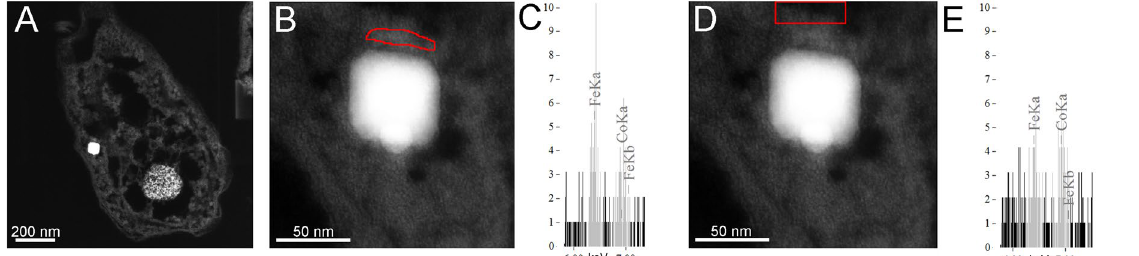
Figure 2. STEM-HAADF of thin-sections of a cryo-fixed cell from cultured Magnetofaba australis strain IT-1. ( A ) Low magnification image showing the cytoplasm and a Fe 3 O 4 magnetosome. ( B and D ) show high magnification images of the Fe 3 O 4 magnetosome. The selected regions in ( B and D) are the masks used to extract the EDS spectra shown in ( C and E) , respectively. By comparing the relative intensities of Fe and Co in both spectra, we conclude that iron is more concentrated in the region near the magnetosome ( C ) than in the cytoplasm ( E ). It can be seen that, compared to Co, the Fe signal decreases as the distance from the magnetosomes increases.